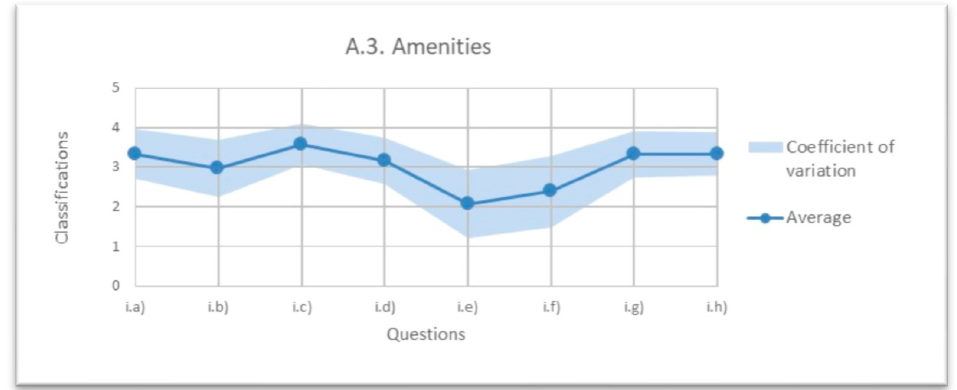
Figure 9. Average ratings of accessibility.